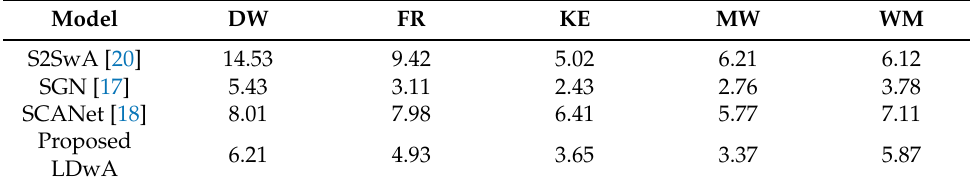
Table 5. Training time in hours for the UK-DALE